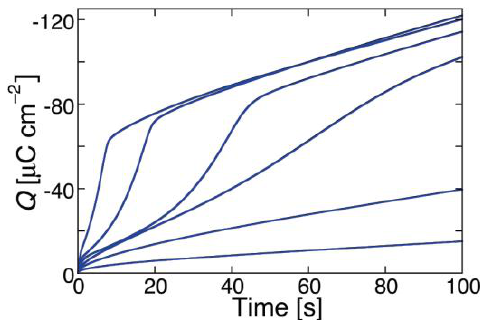
Figure 10. Charge transients at a DPTL/DOPC tBLM in a pH 6.8 buffer solution of 0.1 M KCl and 1 μg/mL SP25A, obtained by jumping from E i = −0.30 V to final potentials varying from −0.50 to −1.00 V by −100 mV increments. (Reprinted with permission from [18]. Copyright 2015, Elsevier).